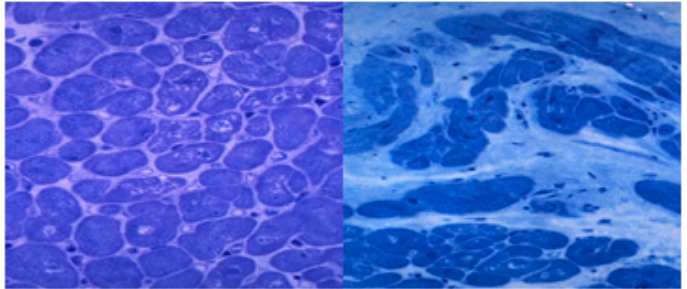
Figure 2. Histological lesions in the subclinical and clinical periods of human alcoholic cardiomyopathy. Left ventricle apical biopsy. Semithin section. Toluidine blue staining x 400 magnification. Left: Subclinical period with slight signs of myocytolysis, disarray, and myocyte hypertrophy (arrows). Right: End-stage clinical period with myocyte loss, diffuse interstitial fibrosis and intense nuclear and myocyte hypertrophy (white arrows).